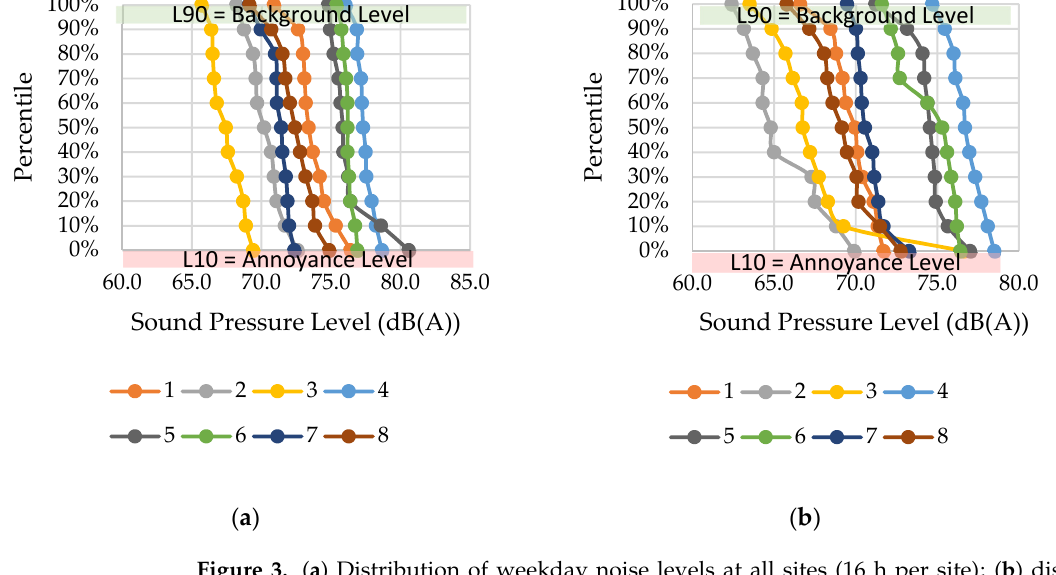
Figure 3. ( a ) Distribution of weekday noise levels at all sites (16 h per site); ( b ) distribution of weekend noise levels at all sites (16 h per site). Table 7. Mean morning, afternoon, and evening noise